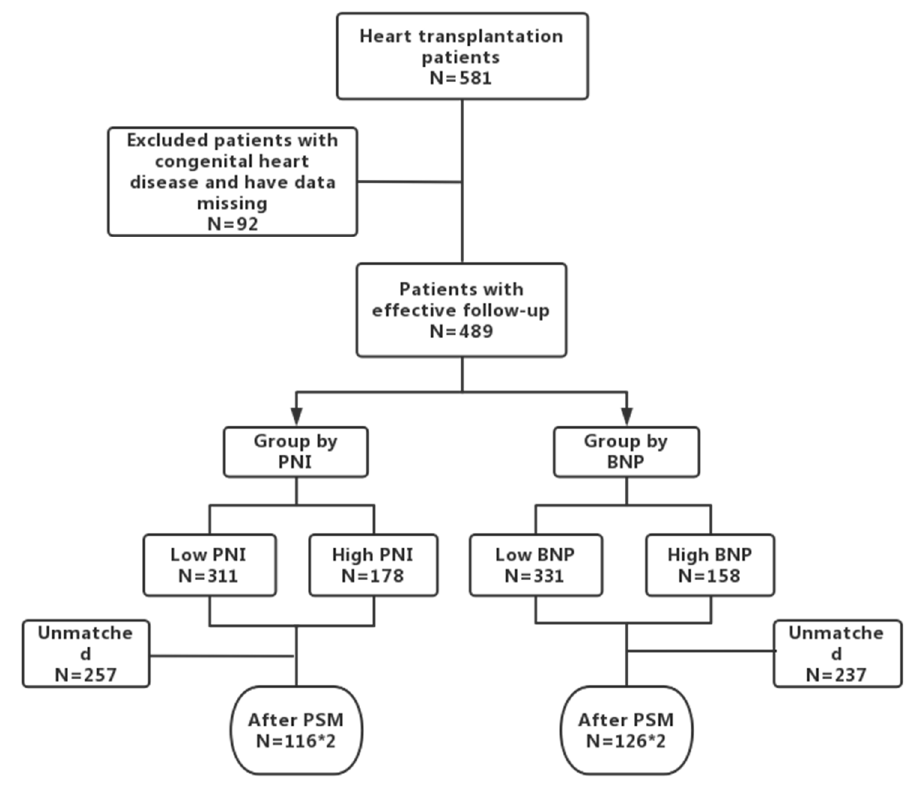
Figure 1. Study cohort. *2 means there were some pairs of patients after PSM. Table 1. Baseline patient characteristics based on PNI and